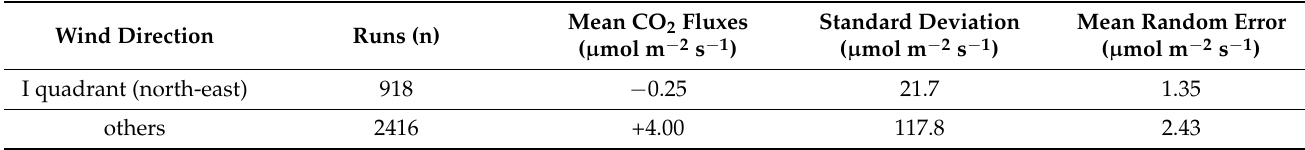
Figure 8. Percentage frequency distribution of CO 2 fluxes in the 10 ◦ sectors for runs in unstable (left) and neutral (right) conditions, respectively. CO 2 fluxes are divided in uptake (white), moderate emission (grey), and higher emission (black). Table 2. Comparison between mean hourly CO 2 fluxes, as measured during the whole experimental period, in function of wind direction (one